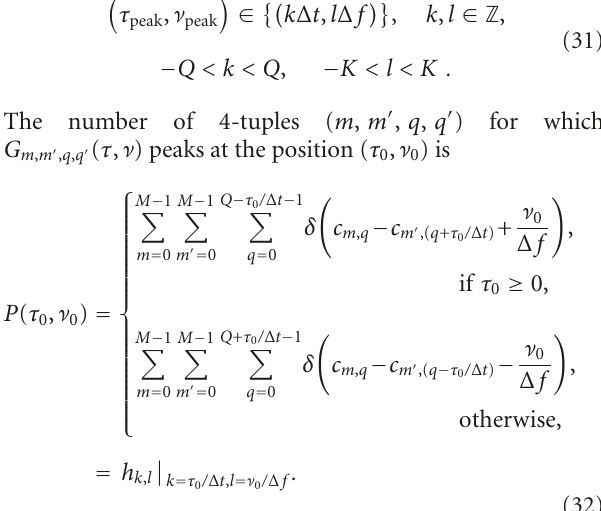
peak at a shift of Δ f from ν peak . Hence most of the energy of each subpulse ambiguity function is located within an area of 4 Δ f Δ t around ( τ peak , ν peak ). For di ff erent values of ( m , m (cid:6) , q , q (cid:6) ), the shape of G m , m (cid:6) , q , q (cid:6) ( τ , ν ) remains the same, and only the position of its peak in the delay-Doppler space changes. The set of possible values of ( τ peak , ν peak ) is given